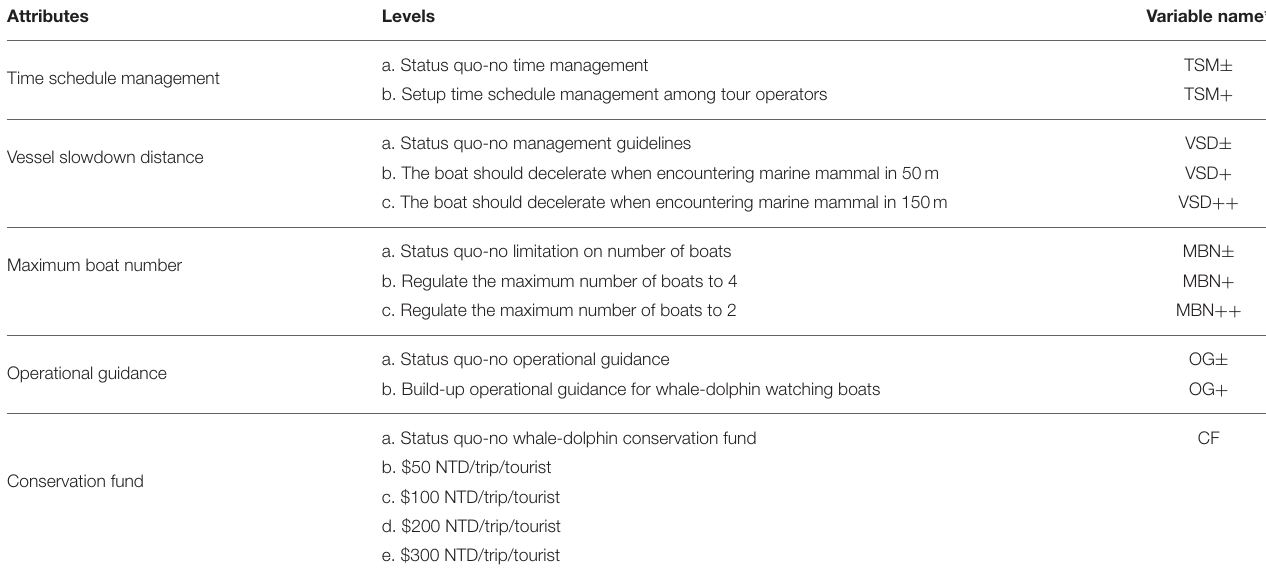
TABLE 1 | Attributes and their levels with variable names used in the choice experiment.